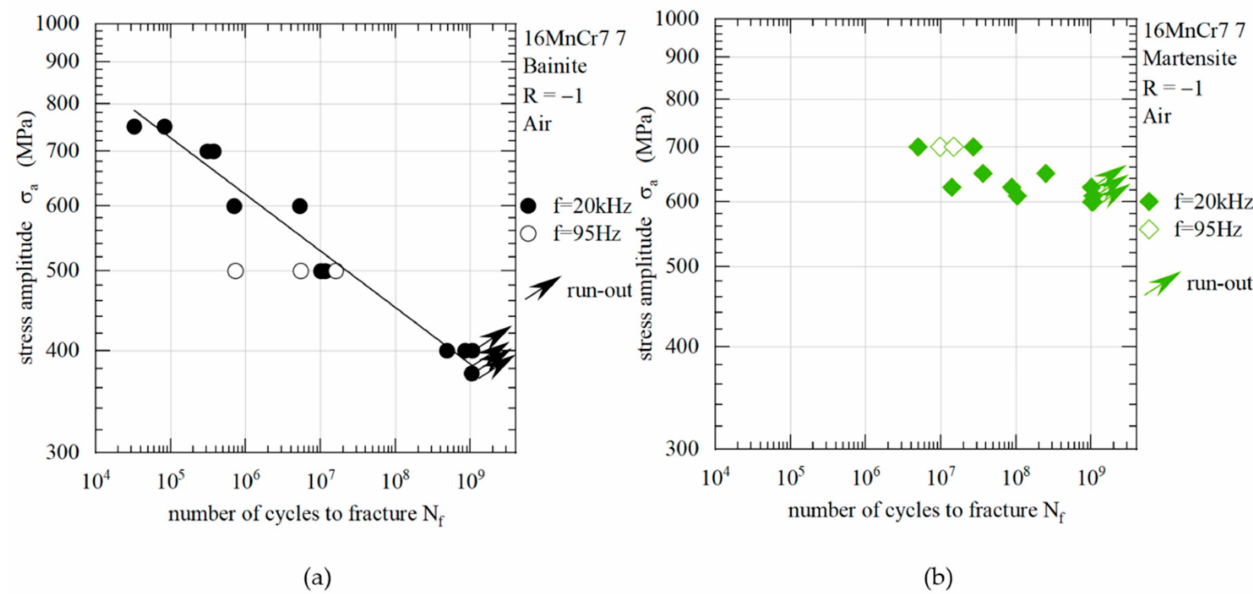
Figure 10. Wöhler S-N Diagram showing the fatigue life for the 16 MnCrV7 7 steel at two testing frequencies of f = 95 Hz and f = 20 kHz for ( a ) the bainitic, and ( b ) the self-tempered martensitic